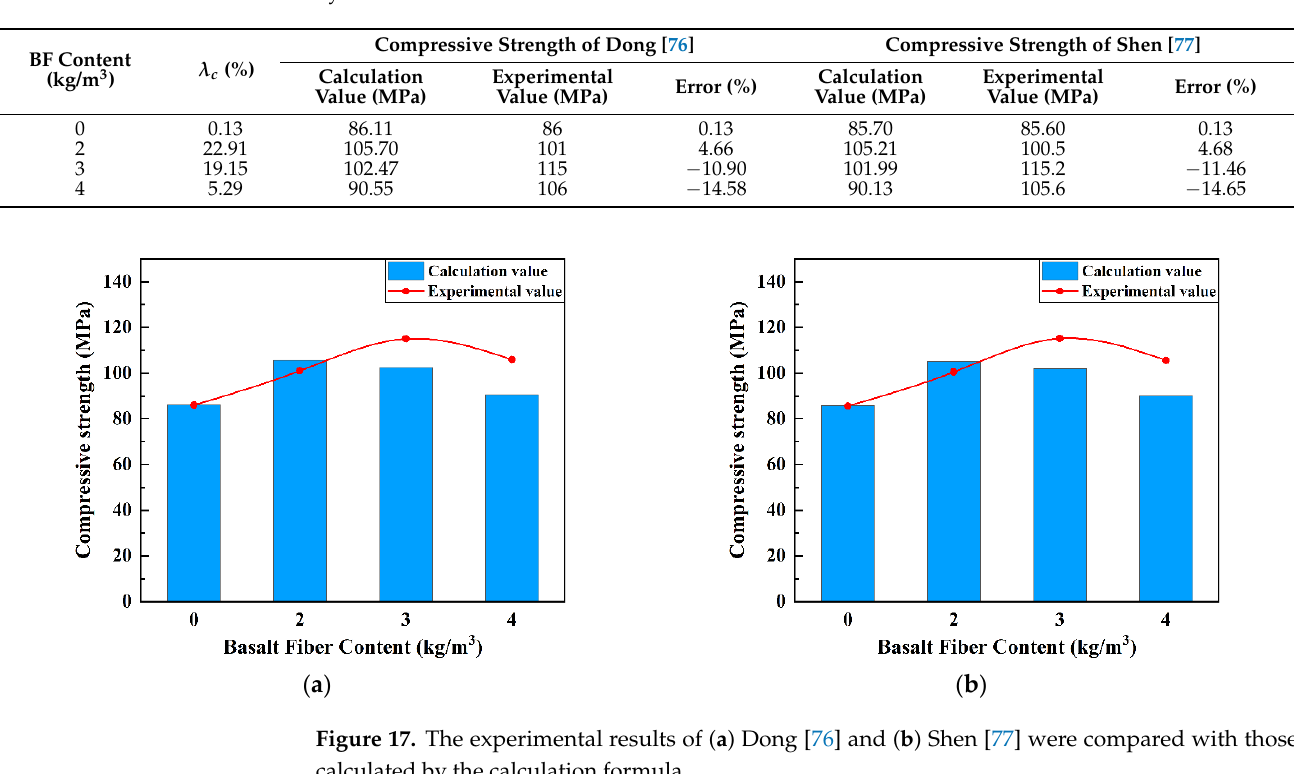
Table 7. The experimental results of Dong [76] and Shen [77] were compared with those calculated by the calculation formula.